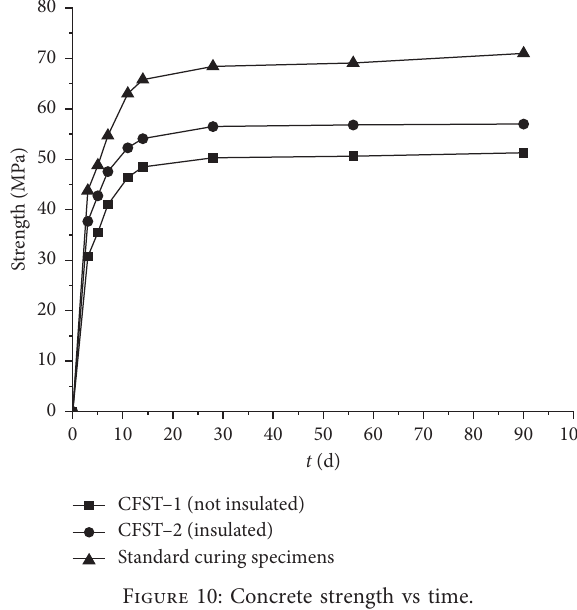
Figure 10: Concrete strength vs time.